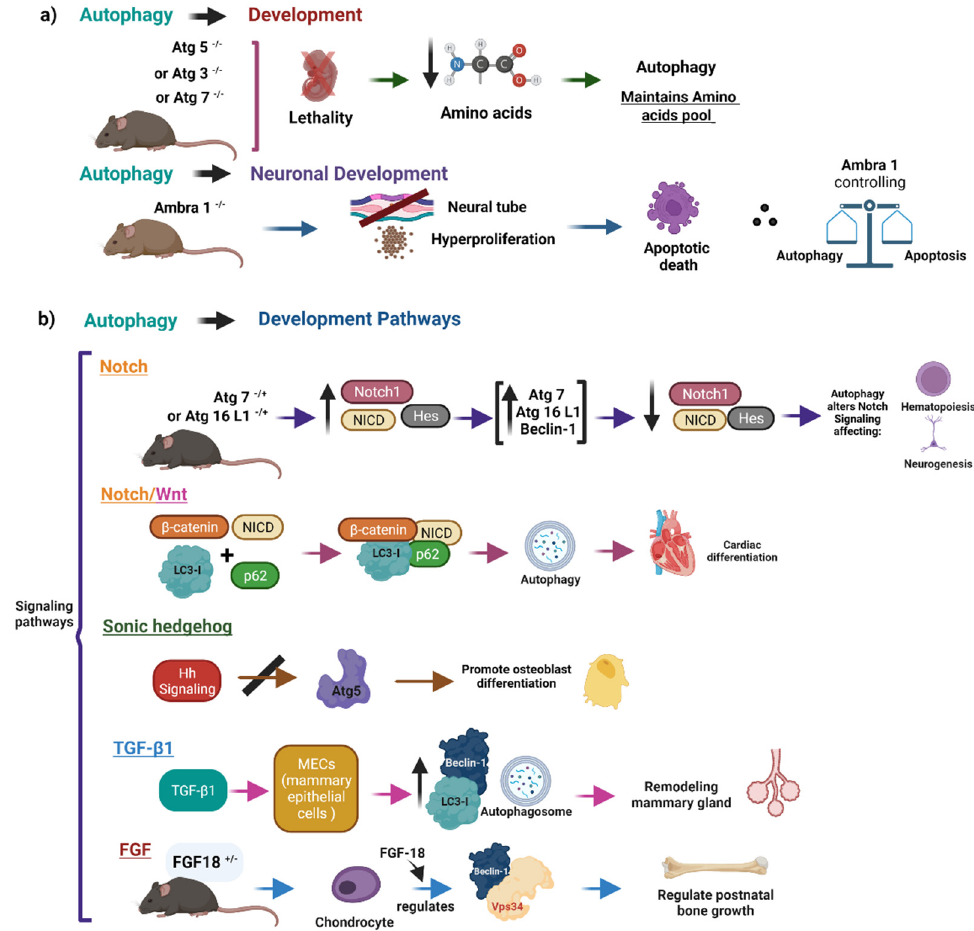
Figure 4. The role of autophagy in the regulation of embryonic development. ( a ) Autophagy as a regulator of embryonic development and neural development. Mouse models suggest that autophagy is essential for development. ( b ) Autophagy interacts with developmental signaling pathways, among them Notch, Wnt, Sonic Hedgehog, FGF, and TGF β . Impairments in the crosstalk between these pathways and autophagy could likely be the cause of the defects in the generation of embryonic structures. See the text above for more details. “Created with BioRender.com (accessed on 1 May 2022).”